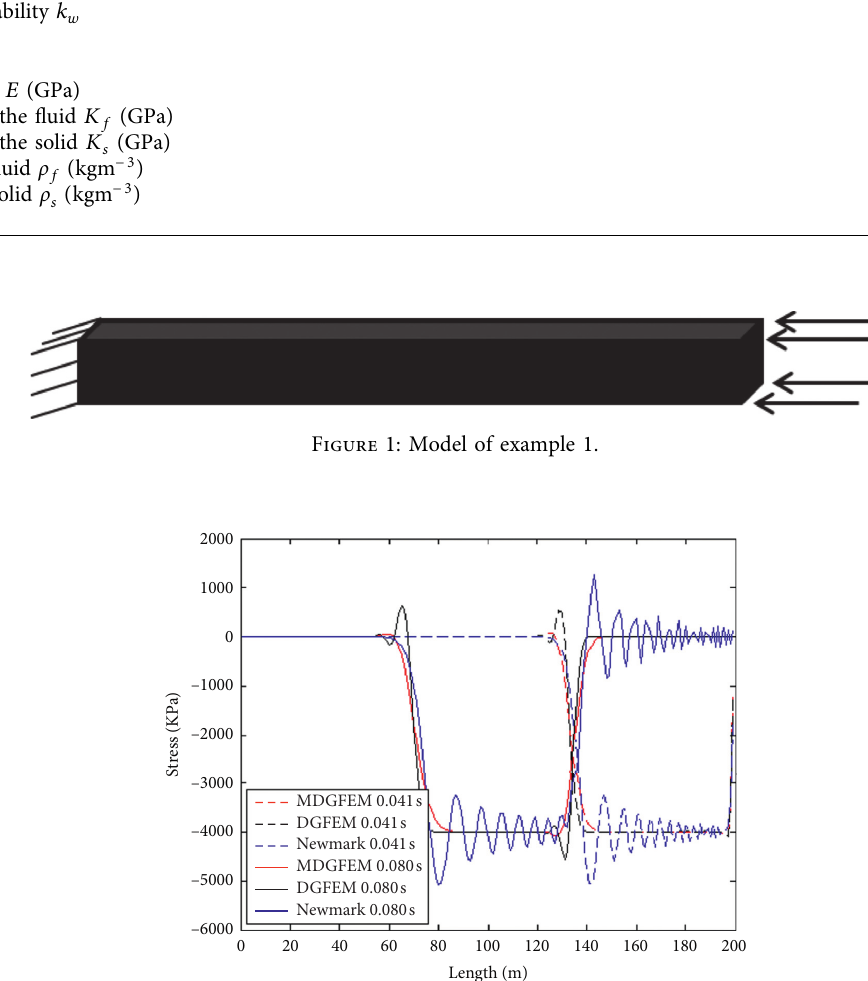
Figure 2: Stress profiles of different methods at t � 0.041s and t � 0.08s.